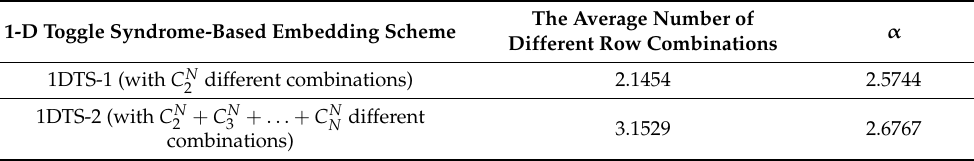
Table 3. Comparisons of computational complexity between 1DTS-1 and 1DTS-2.